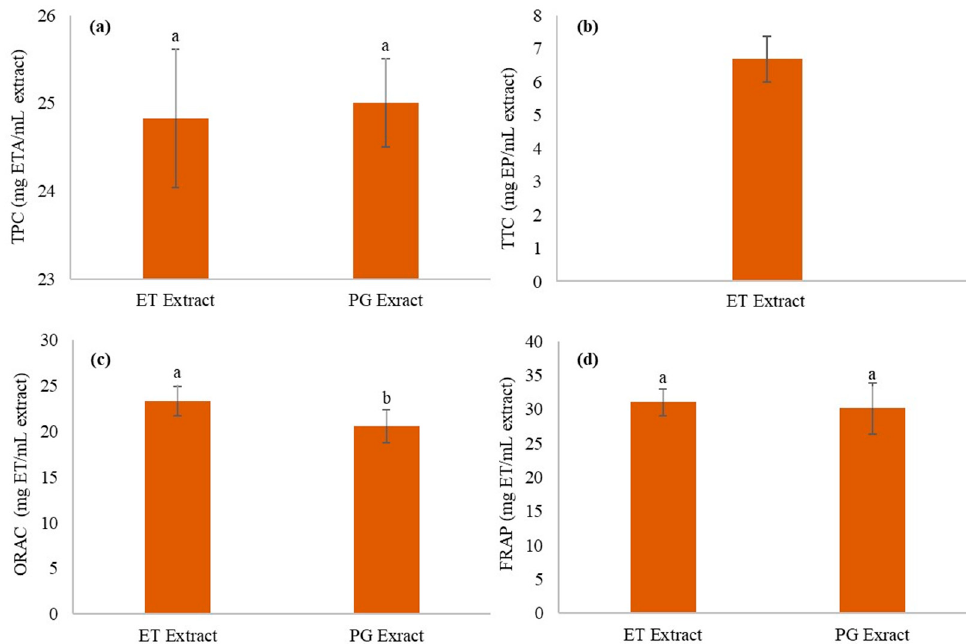
Figure 1. Comparison of ( a ) total phenolic concentration, ( b ) total tannin concentration, antioxidant activity by ( c ) ORAC, and ( d ) FRAP from extractive processes using ethanol and propylene glycol. Equal a,b letters in the same column indicate no statistically significant difference between the averages, assessed by the Tukey test at the 95% level of significance.